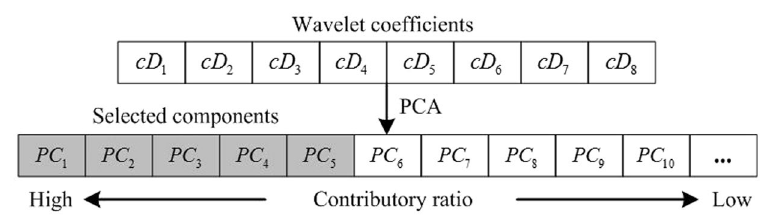
Figure 4. Low-dimensional feature vector generated by PCA using wavelet